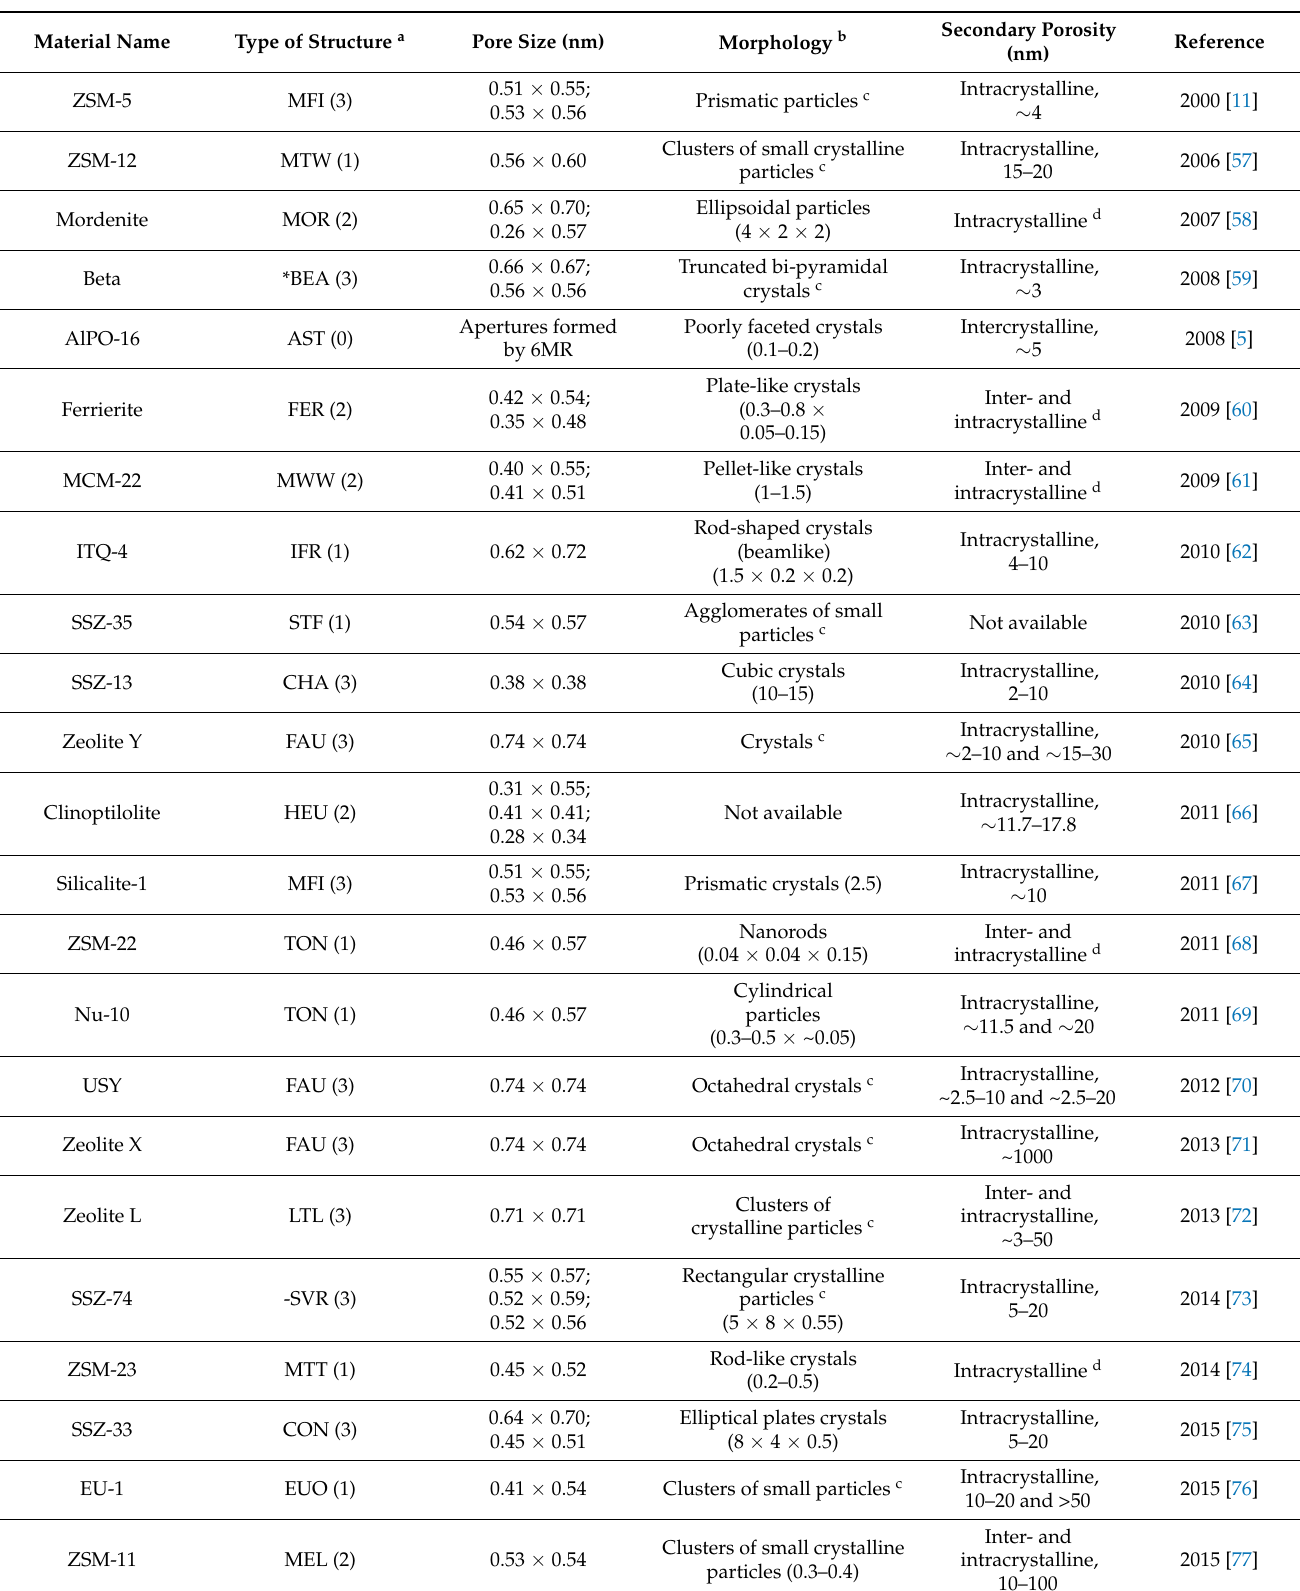
Table 2. Previously reported hierarchical zeolites prepared by alkaline